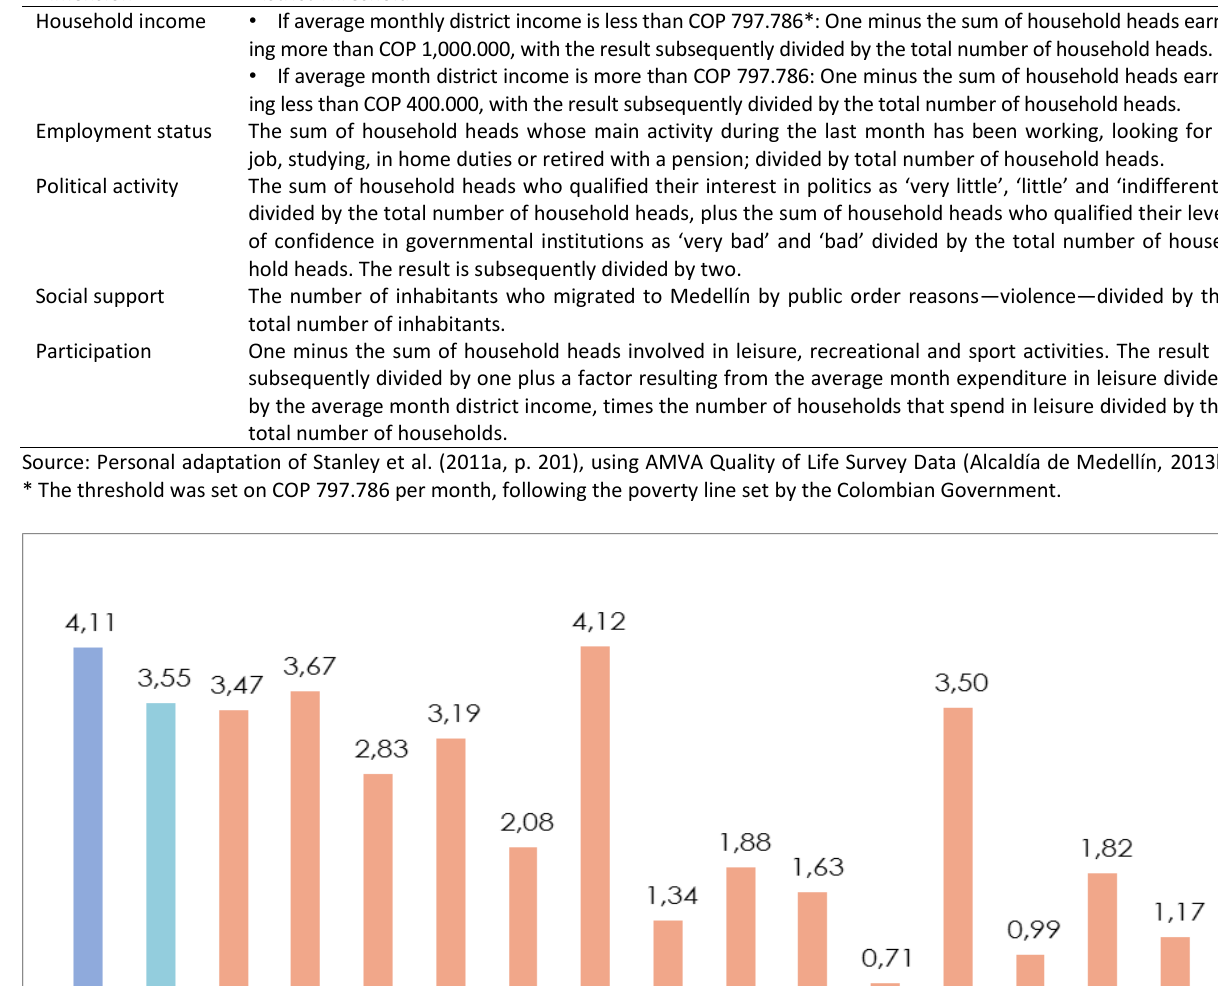
Table 4. Adapted thresholds for the indicators of social exclusion. Dimension